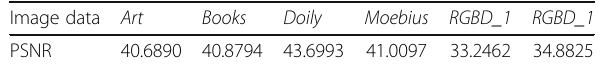
Table 3 PSNR performances achieved by AMF and